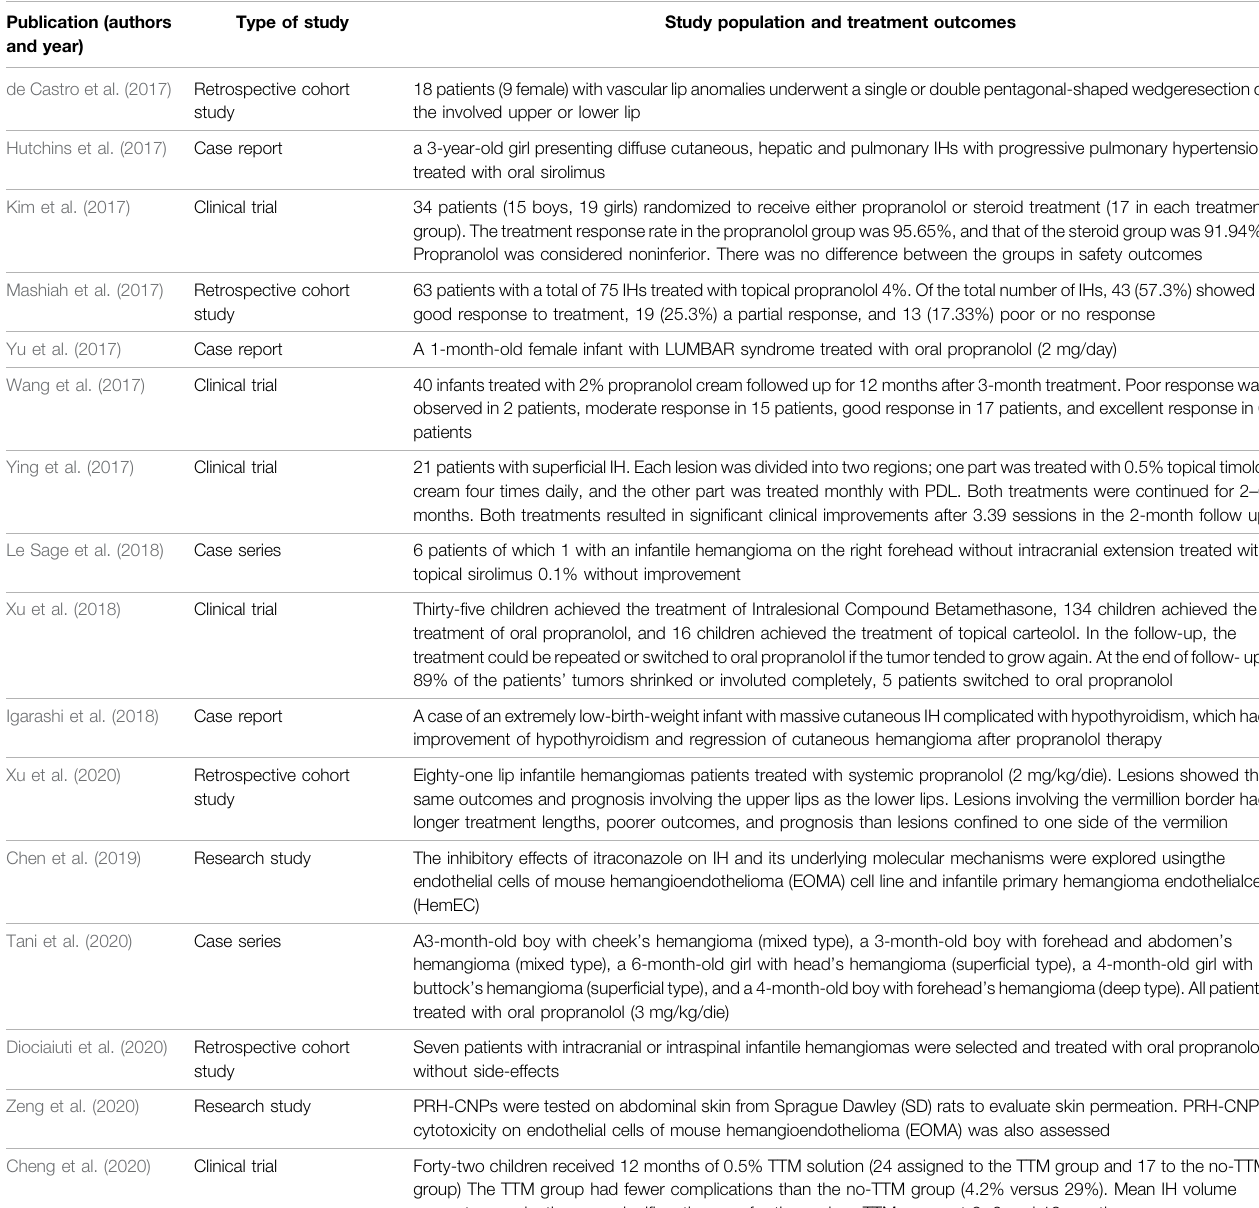
TABLE 1 | Papers concerning treatment of cutaneous infantile hemangioma